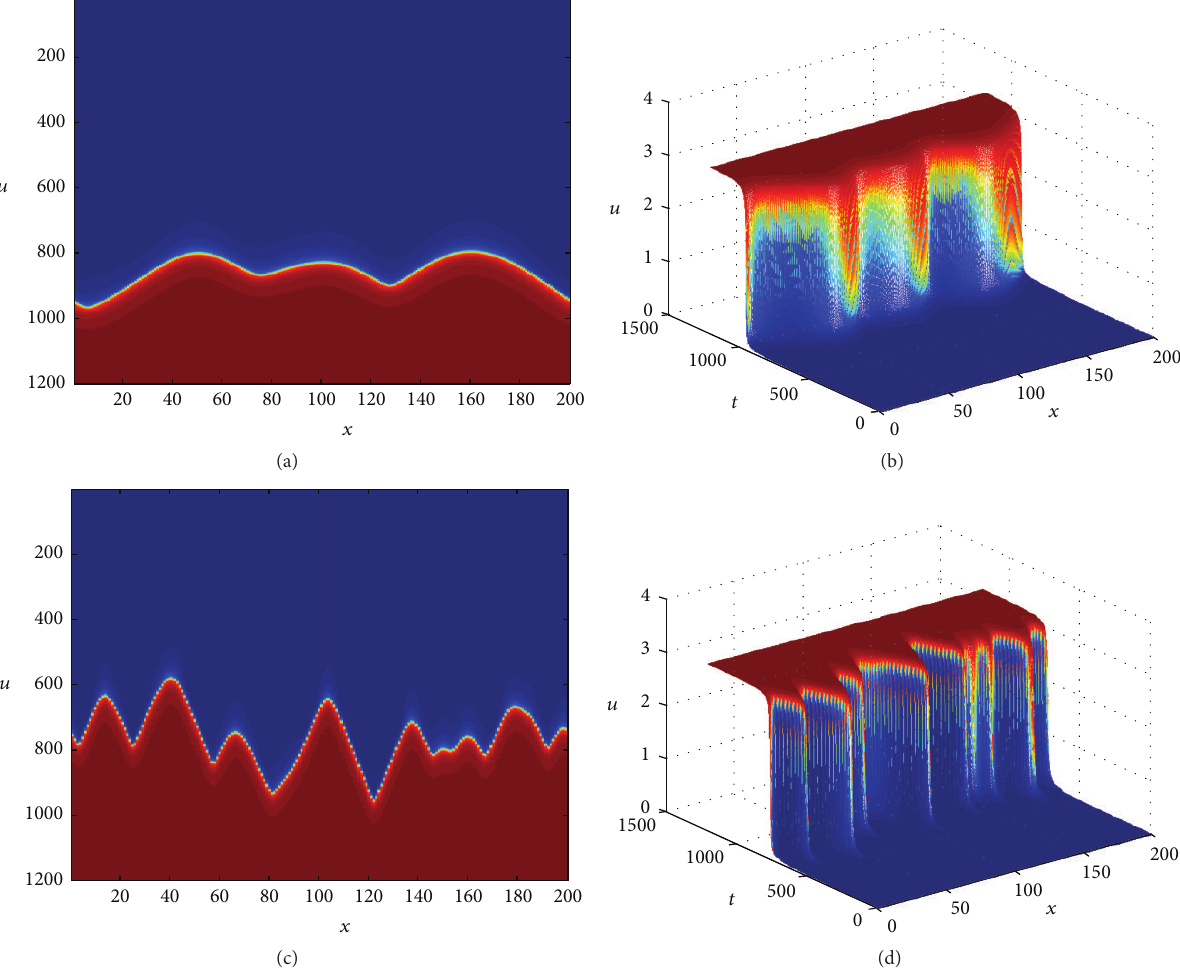
Figure 2: The snapshots (a, c) and surface plots (b, d) of one-dimensional KiSS model (32) showing the effect of diffusion (a) at 𝛿 = 1 and (b) at 𝛿 = 0.1 . Simulation runs for 𝑁 = 200 .